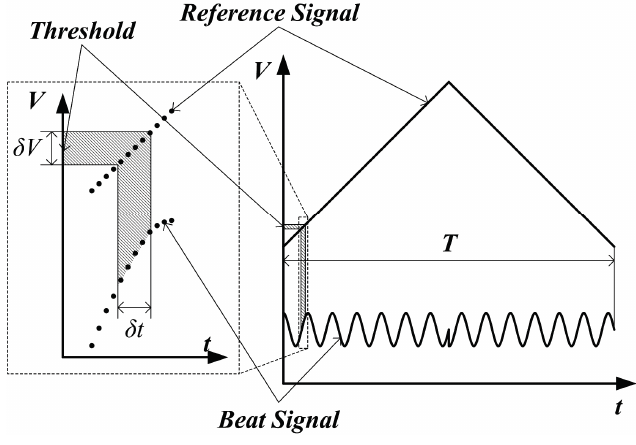
Figure 10. The procedure of determination of starting